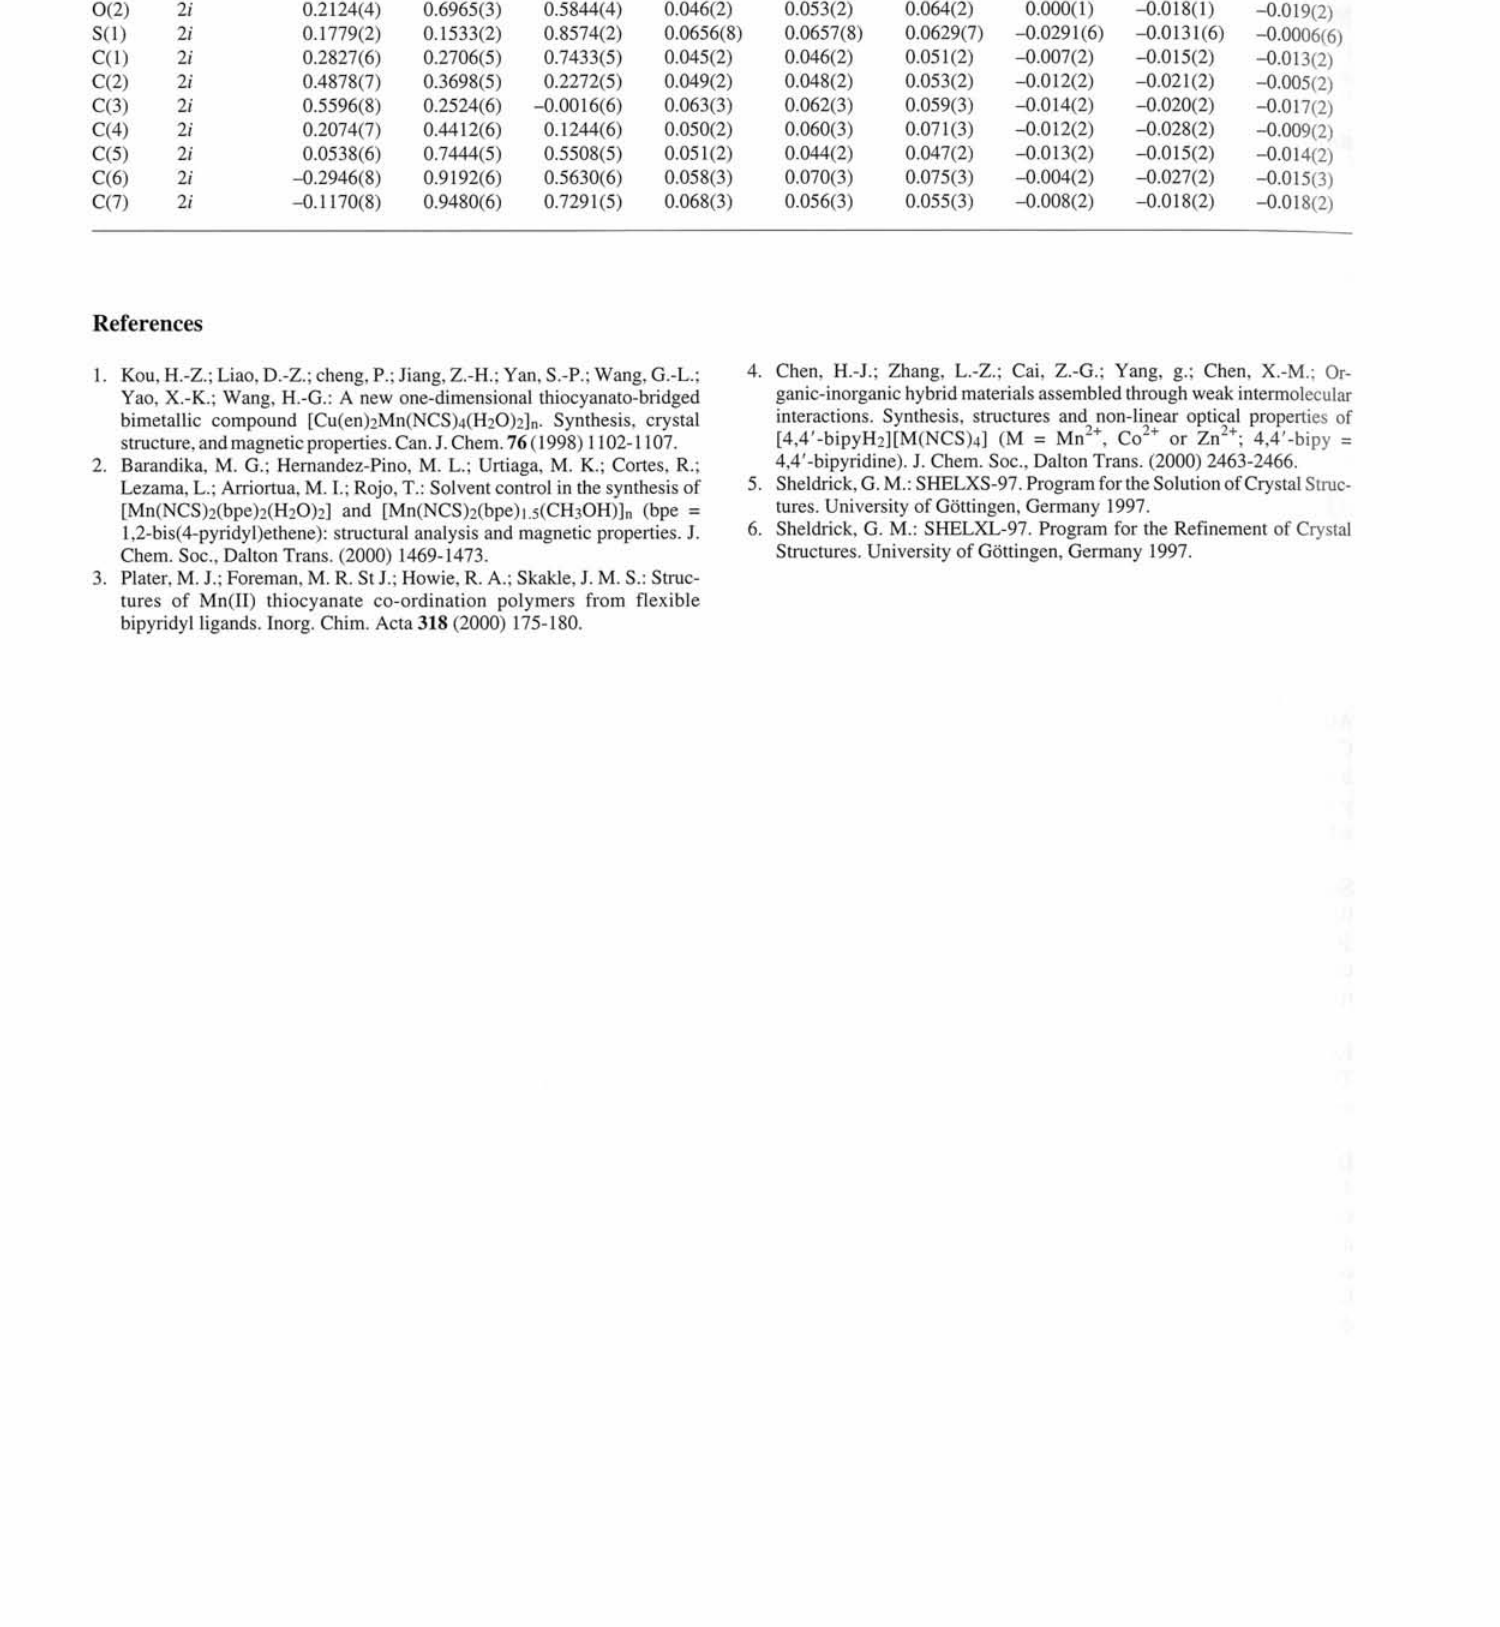
Table 3. Atomic coordinates and displacement parameters (in A